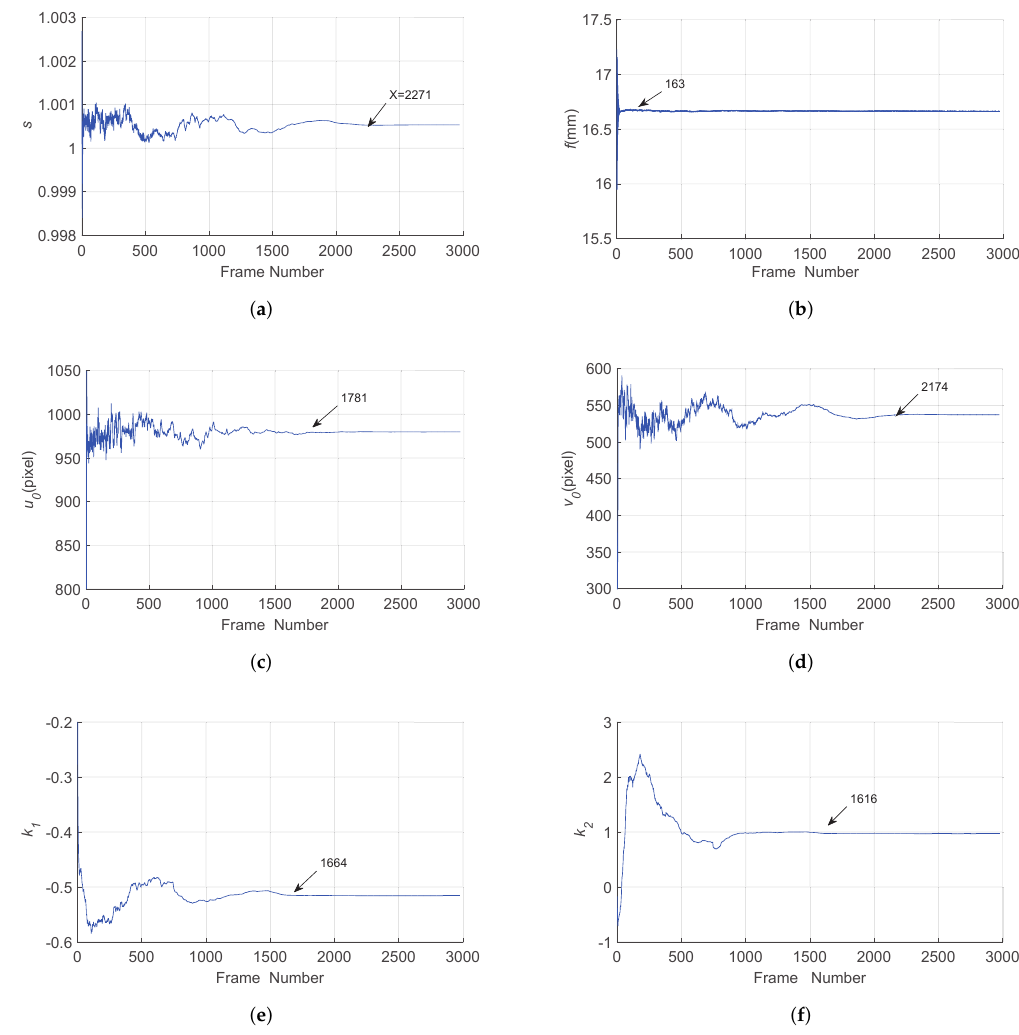
Figure 8. Estimation results of the parameters.(a) s (b) f (c) u 0 (d) v 0 (e) k 1 (f) k 2